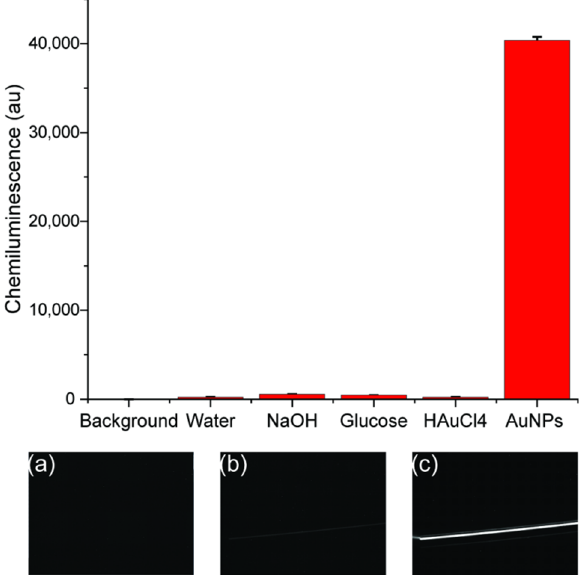
Figure 6. Comparison of CL signals generated from background and luminol–NaOCl mixed with four blank solutions: water, 2 mM NaOH, 1M glucose and 0.05% HAuCl4, and synthesized AuNPs. Inset ( a – c ) were images recorded by CCD camera of background, water blank and AuNPs, respectively.